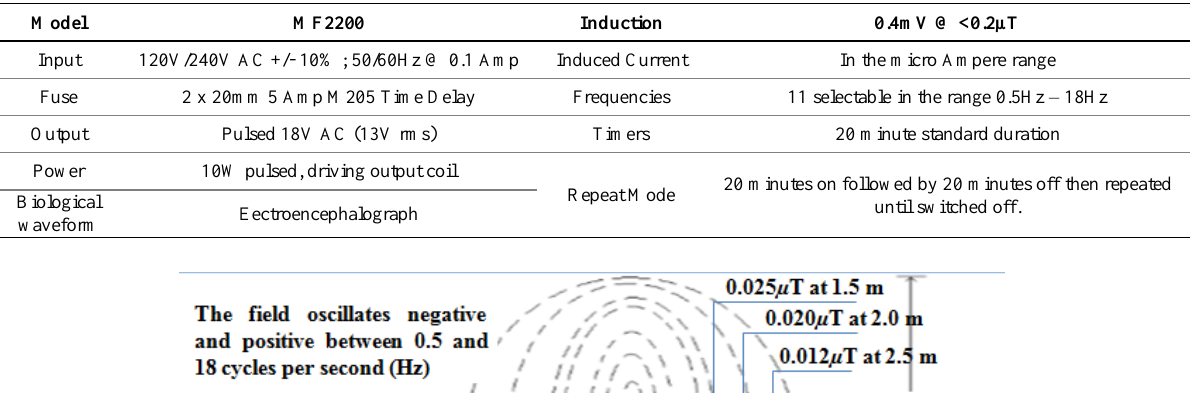
Table 1. System specifications of Magnafield®.